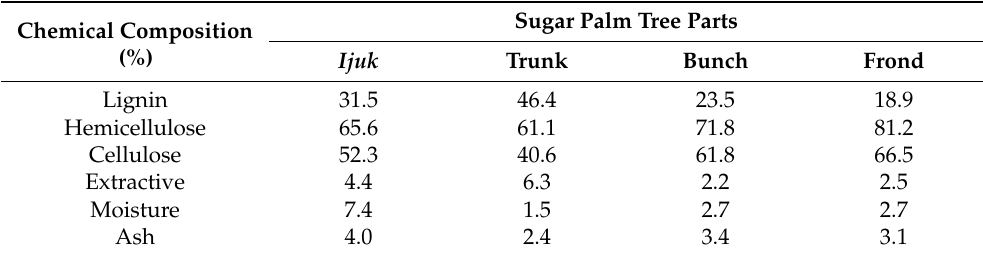
Table 3. Chemical compositions of SPF from different tree parts. Data extracted from Ref. [68]. Creative Common CC BY